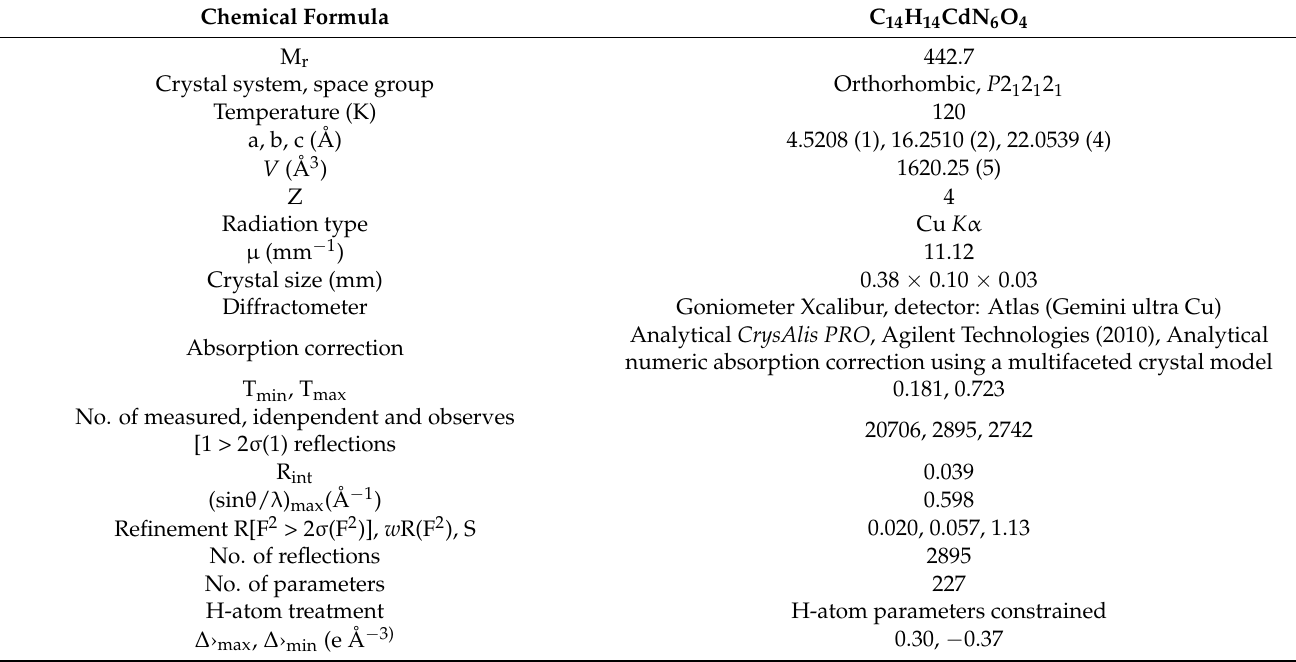
Table 1. Crystal data and structure refinements of complex.